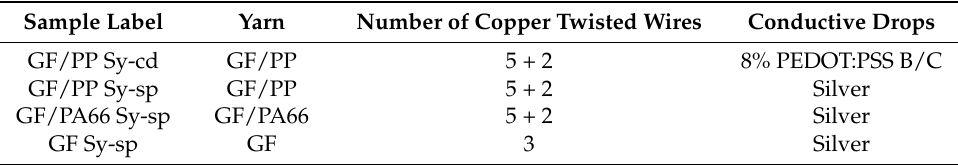
Figure 9. Roll to roll aluminum laboratory device parts: ( a ) rollers N°2 with notch widths A-A and